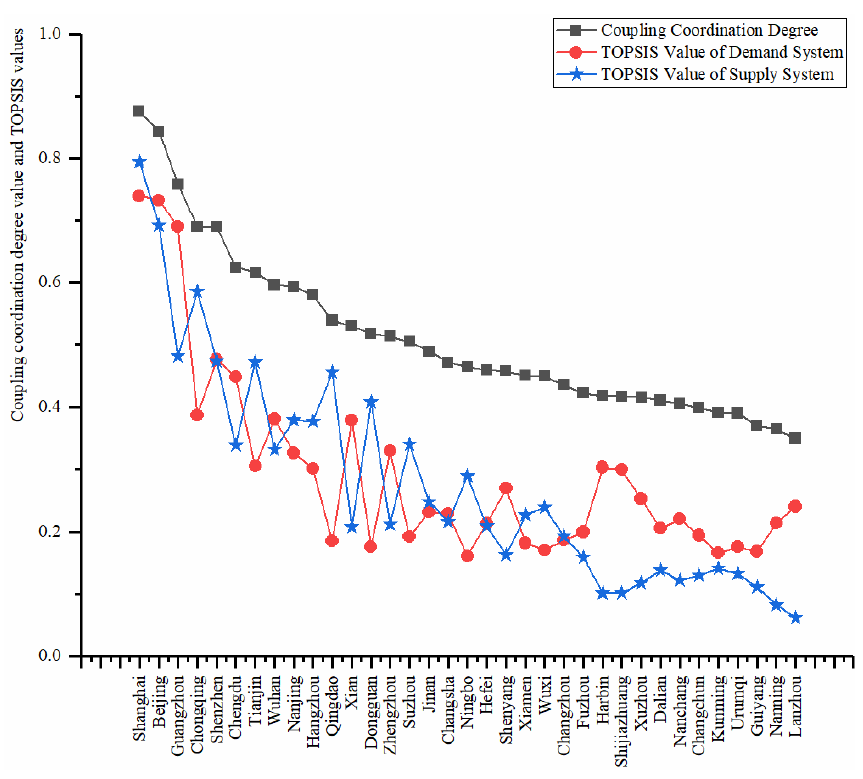
Figure 2. Coupling coordination degree values and TOPSIS values of all cities.